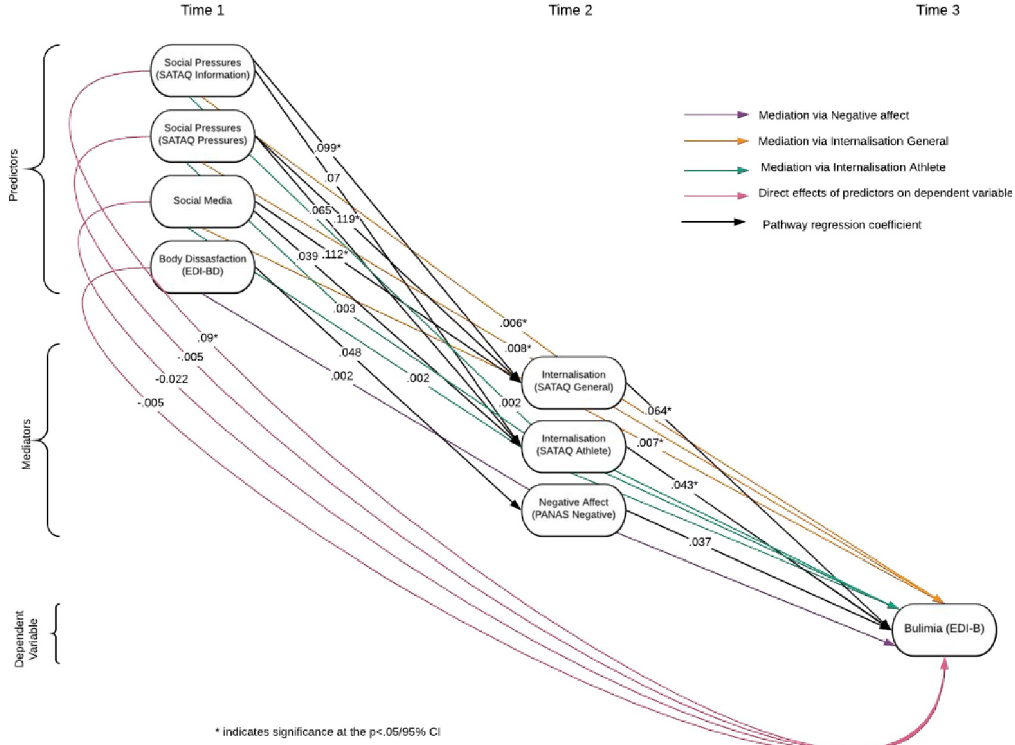
Fig 3. Visual of indirect, mediated, and direct effects.